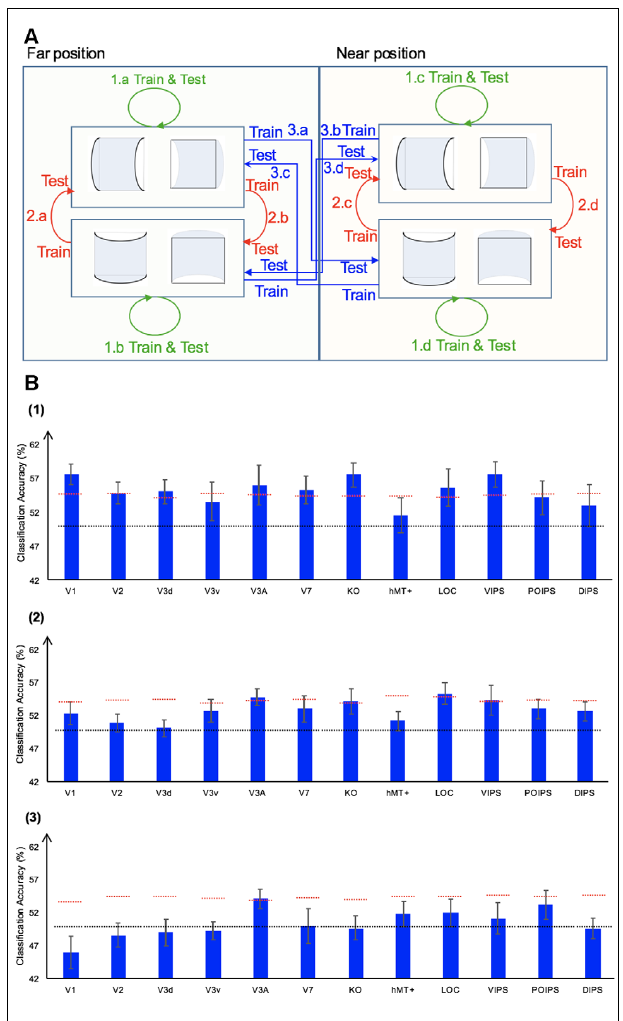
FIGURE 3 | Sign of curvature classification and results. (A) Illustration of the types of the sign of curvature classification performed. 1.a, 1.b, 1.c, and 1.d represent same-type stimuli classification. 2.a, 2.b, 2.c, and 2.d represent transfer the sign of curvature classification of surfaces at the same depth position. 3.a, 3.b, 3.c, and 3.d represent transfer the sign of curvature classification of surfaces at different depth positions. (B) The accuracy of classification for convex vs. concave discrimination. (1) The accuracy of classification for the sign of curvature discrimination for same-type stimuli. (2) The transfer sign of curvature classification of surfaces at the same depth position. (3) The transfer sign of curvature classification of surfaces at different depth positions. The red horizontal dotted lines indicate the baselines of statistical significance for ROIs. The locations of these lines indicate the upper 99.6% percentile of the distribution of the accuracy of classification of the permutated data. The black horizontal line indicates the chance level for two-class classification. The error bars depict the standard error of the mean across subjects ( n = 8). BOLD signal pattern reflects a more generalized sign of surface curvature representation and SVM classified surfaces based on these